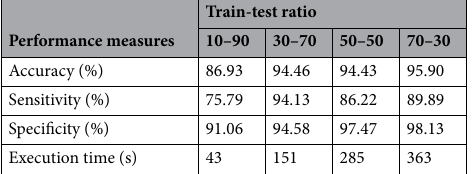
Table 3. Performance measures obtained on 3-layer CNN